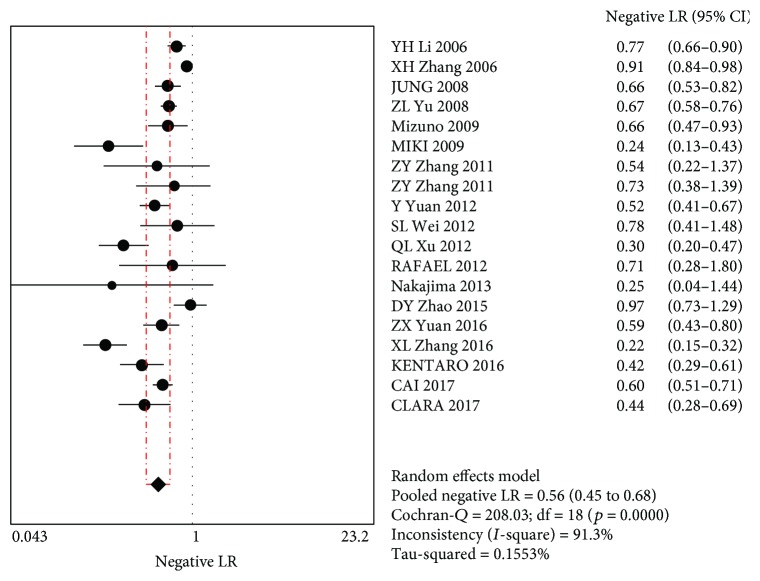
Merging negative likelihood ratios.